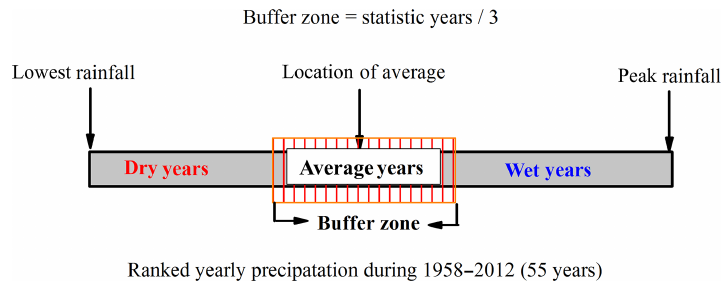
Figure A1. The classification method for different rainfall conditions (wet, average, and dry years) in the Yalu and Ai rivers.